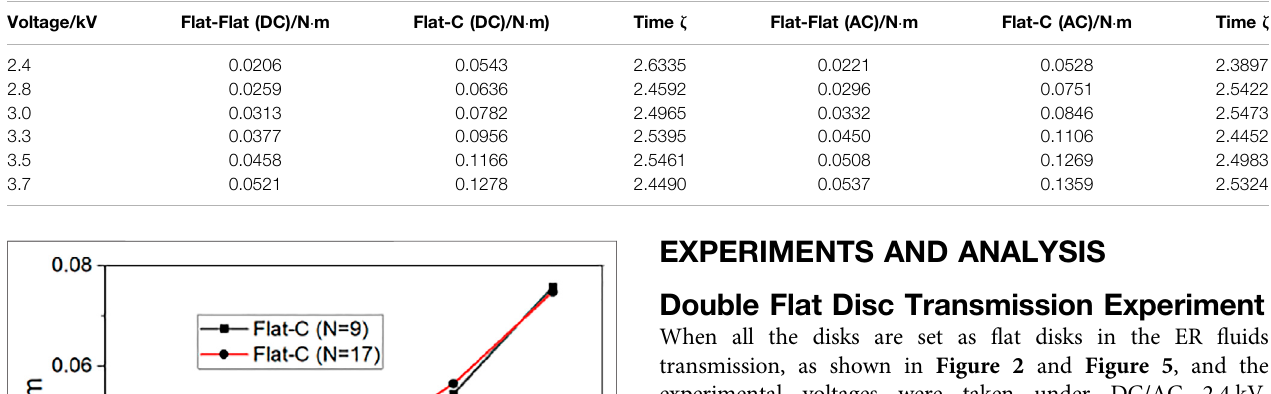
TABLE 2| Comparison oftheaverageoutputtorque ofthe fl atdiskandthecorrugateddiskunderdifferenthighpressures( ζ denotestheratiooftheoutput torque ofthe fl at- cross disk and the double-plane disk). Voltage/kV Flat-Flat (DC)/N · m